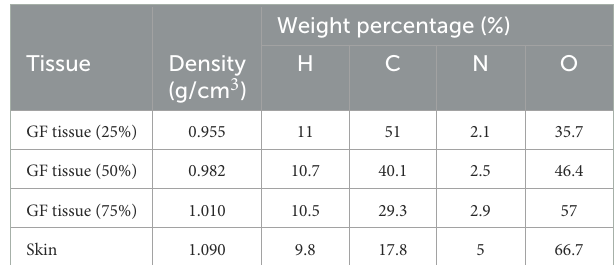
TABLE 1 Elemental properties and densities of the modeled breast layers